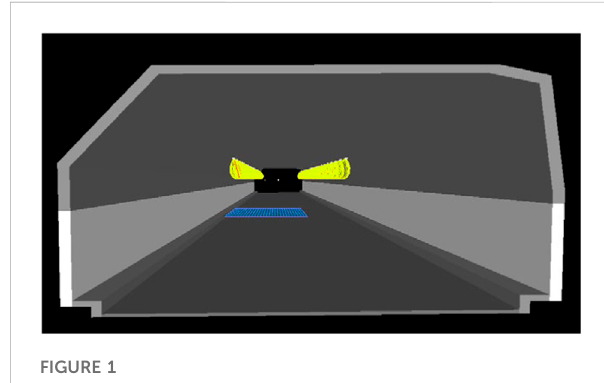
FIGURE 1 Schematic diagram of tunnel simulation.